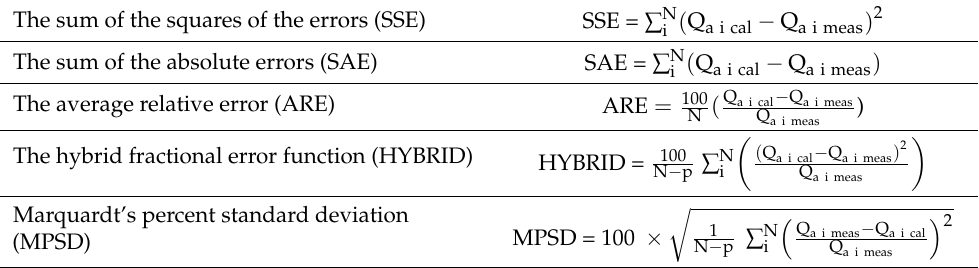
Table 1. The most common error functions used in nonlinear